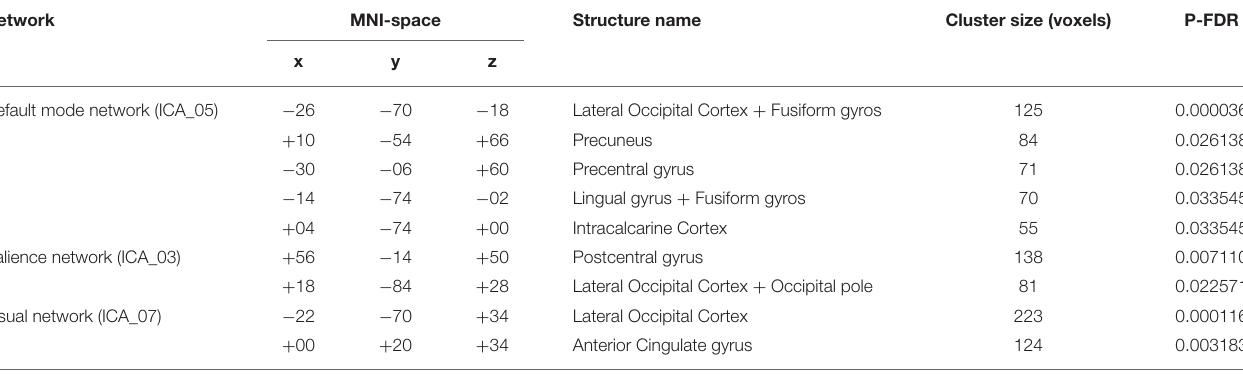
TABLE 2 | Changes in functional connectivity in three networks with cluster names, sizes, locations according to Montreal Neurological Institute (MNI) coordinates, and validity of resulting changes with the Benjamini–Hochberg correction.